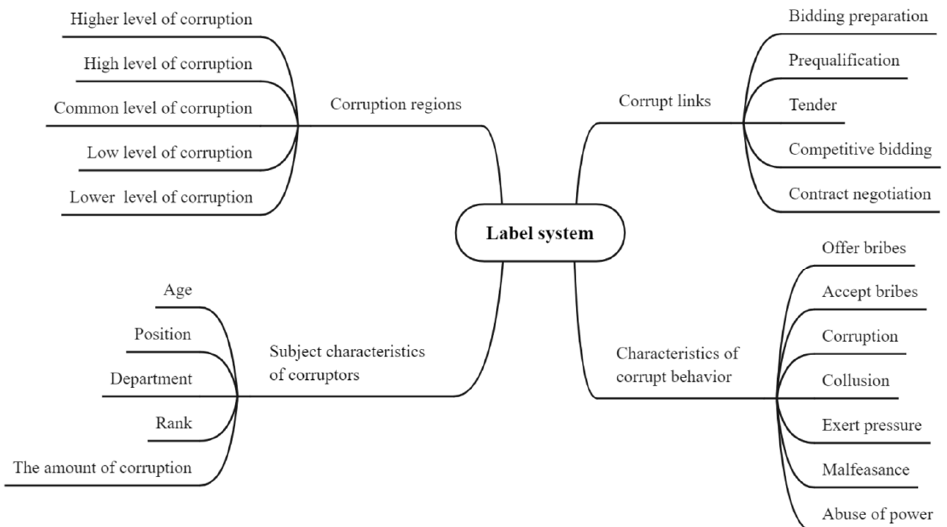
Figure 2. Bidding corruption profile label